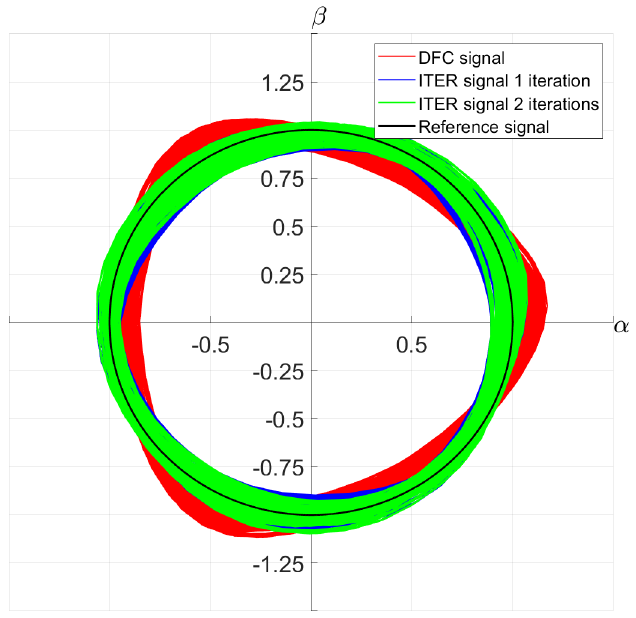
Figure 14. α - β representation of the normalized classic DFC and IVD-DFC signals. The black circle represents the ideal behavior of the signals, i.e., without any multiple harmonics. The signals are referred to a mechanical rotor angular speed of 500 RPM and are sampled at 5